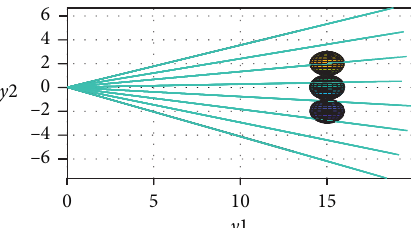
Figure 11: Vertical projection of the 3D lidar’s view for five ob- stacles in 15 m.